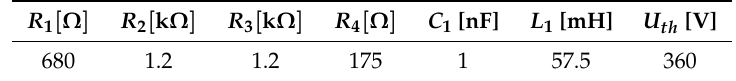
Table 3. Final component value table, of components which were used in the PSpice simulation and prototype